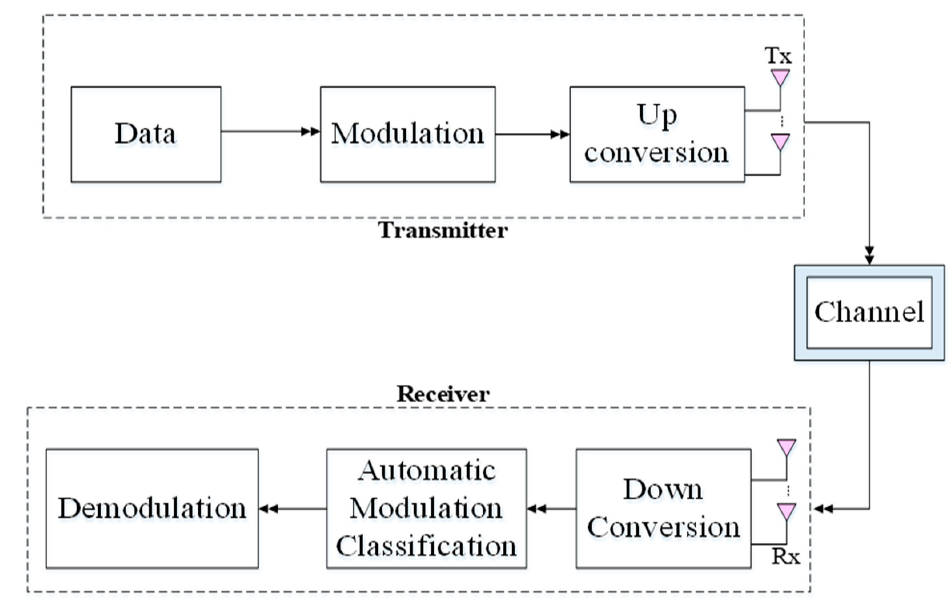
Figure 2. Communication system model.